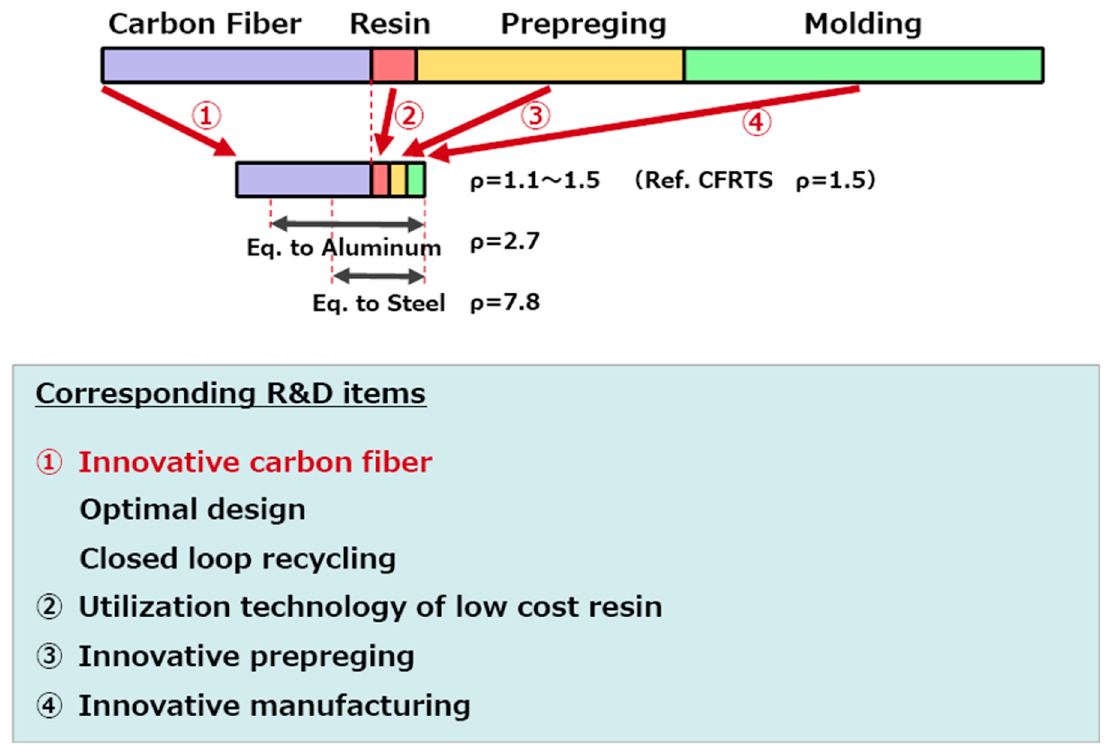
Figure 3. Cost reduction roadmap and corresponding research and development items of CFRPs.